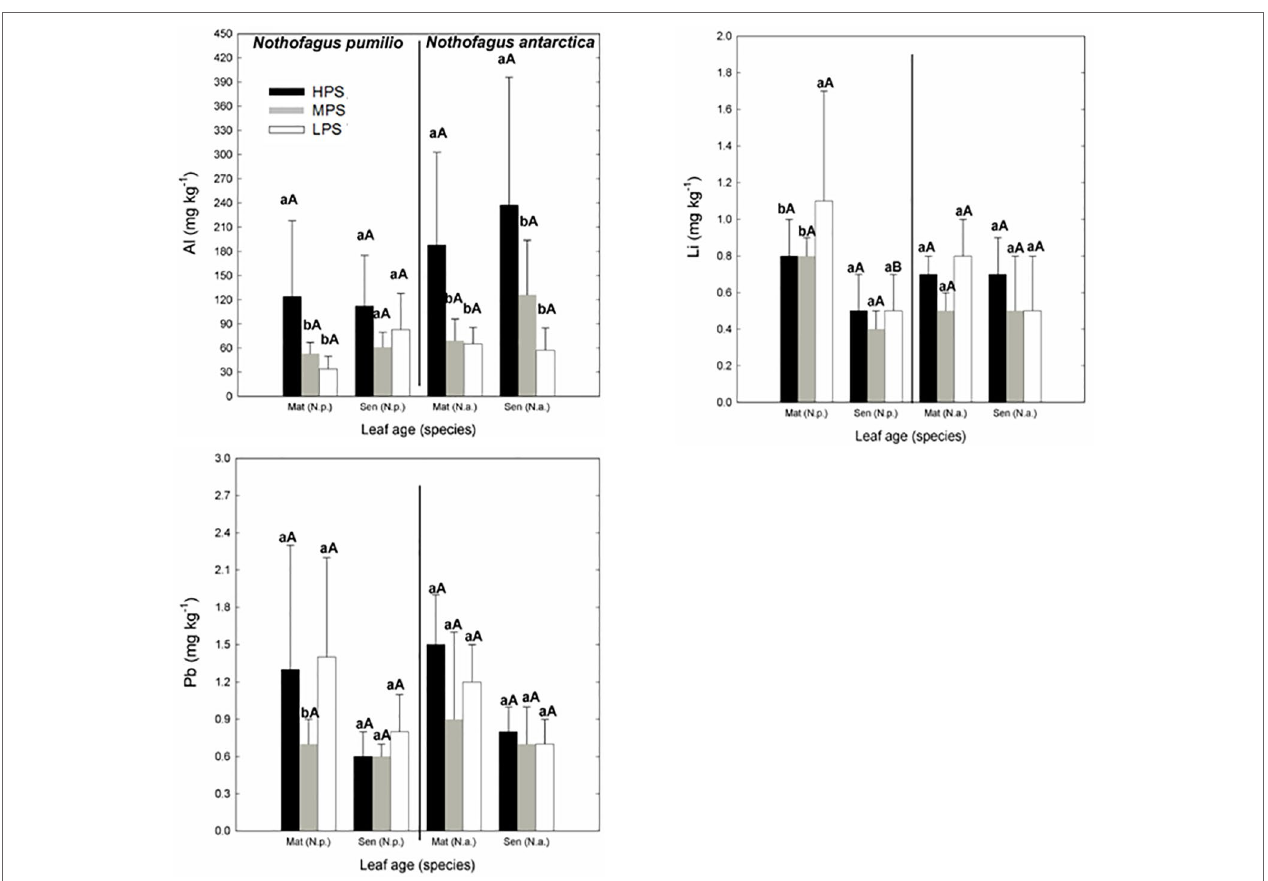
FiGURE 3 | Trace elements (Al, Li, and Pb) concentrations of N. pumilio and N. antarctica leaves from three contrasting sites and collected at two developmental stages (mature and senescent). HPS, highly productivity site; MPS, medium productivity site; LPS, low productivity site. N.p., Nothofagus pumilio ; N.a., Nothofagus antarctica ; Mat, mature leaves; Sen, senescent leaves. Different lower case letters for the same species and age of leaves (mature or senescent) indicate significant differences (P < 0.05) between sites. Different capital letters for the same species and site indicate significant differences (P < 0.05) between age of leaves (mature or senescent). Bars represent the standard deviation of the